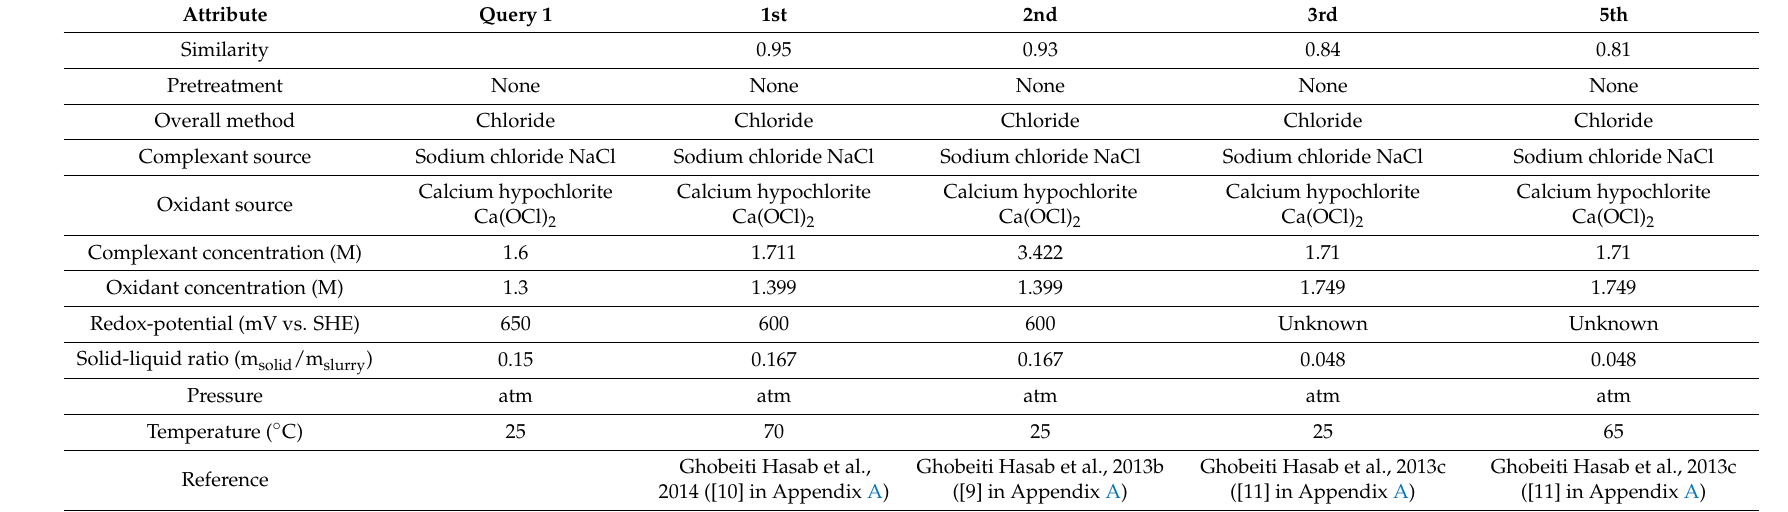
Table 5. Query 1 (Similar Leaching Methods) with the three most similar and the most dissimilar article retrieved from the case